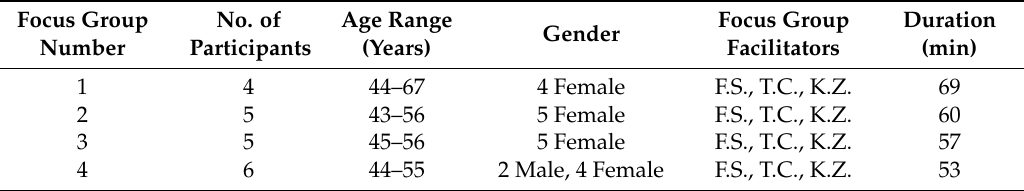
Table 1. Focus group